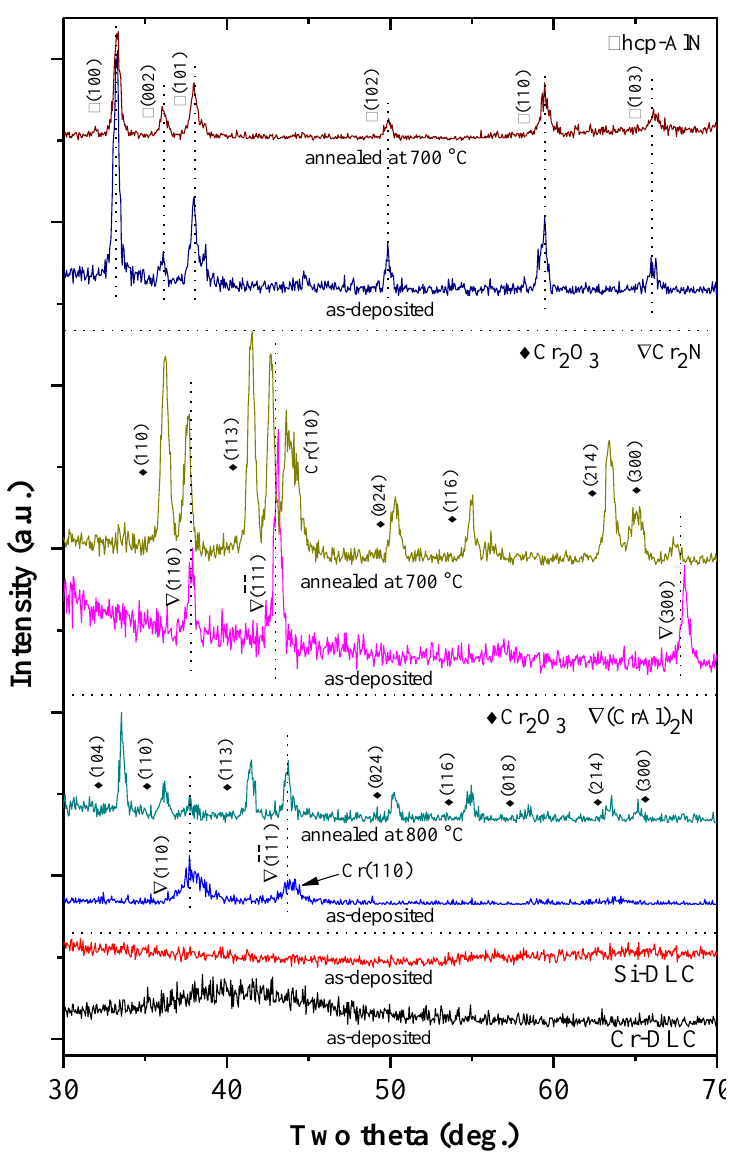
Figure 6. XRD patterns of various